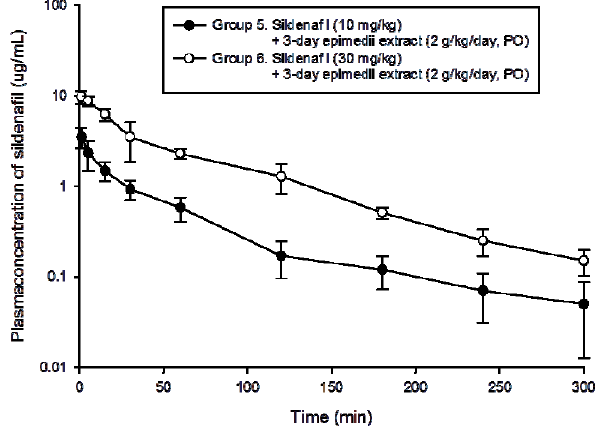
Figure 3. Plasma concentration-time profile of sildenafil in the blood of group 5: high dose Epimedium sagittatum (Sieb. et Zucc.) Maxim extract (2 g/kg/day) for 3 consecutive days and on day 4 + low dose sildenafil (10 mg/kg), group 6: high dose Epimedium sagittatum (Sieb. et Zucc.) Maxim extract (2 g/kg/day) for 3 consecutive days and on day 4 + high dose sildenafil (30 mg/kg). Data are presented as expressed as mean ± standard error of the mean (S.E.), n = 6 for each